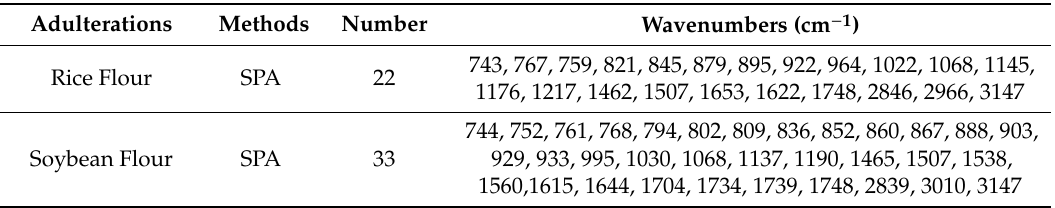
Table 6. Optimal wavenumbers selected by PCA